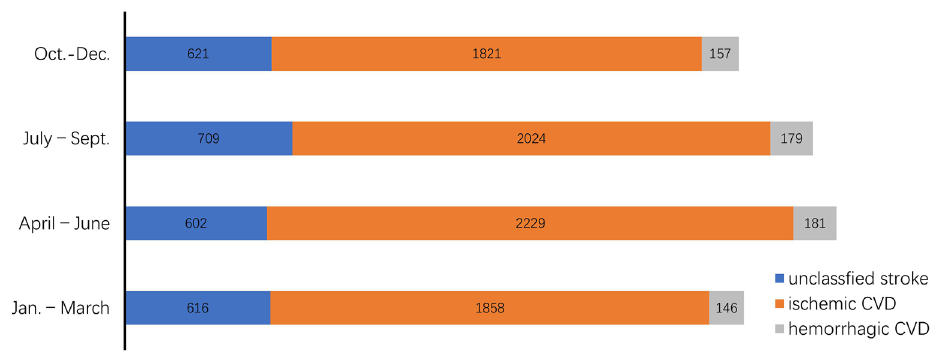
Figure 5. Distribution of CVD in HP patients in different